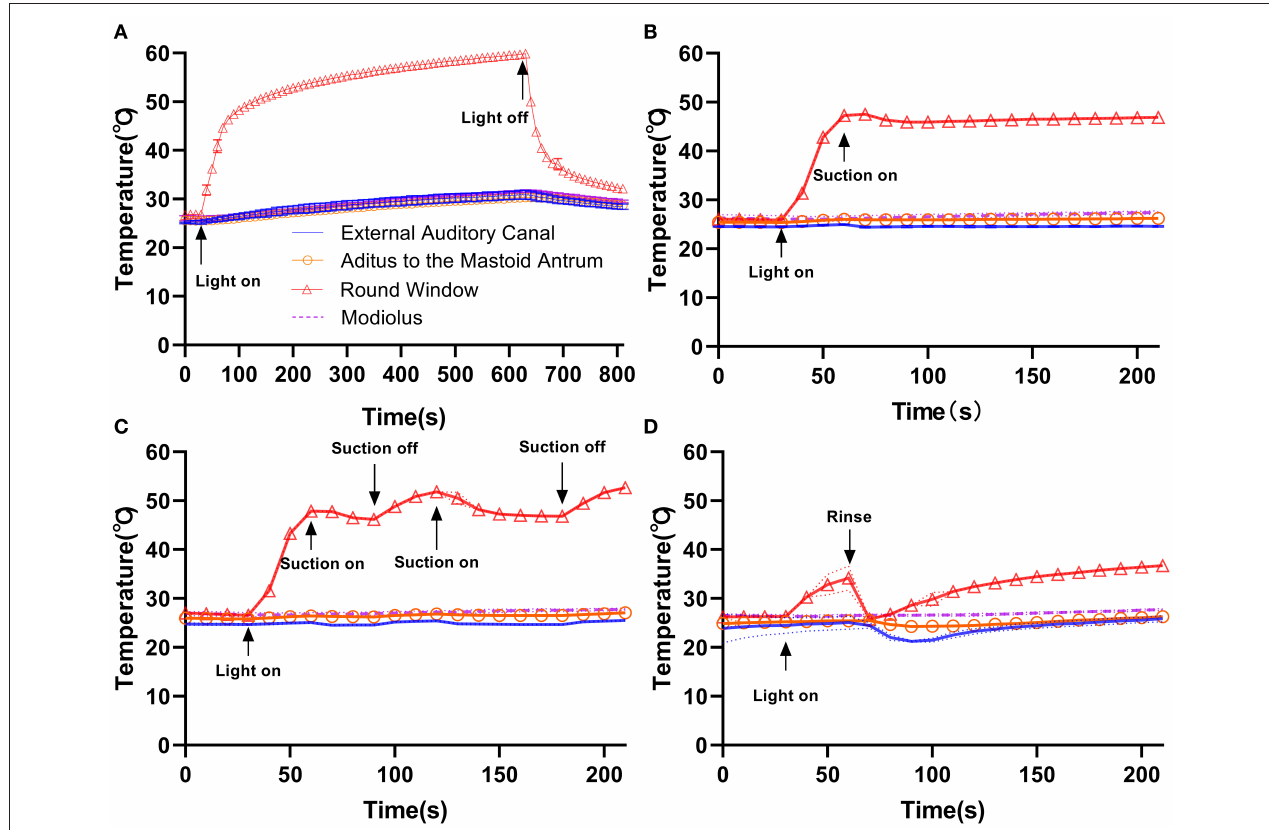
FIGURE 4 | Compared with the control group (A) , continuous suction (B) , discontinuous suction (C) , and rinsing (D) resulted in different cooling effects in temporal bone with the Neuro-0 endoscope under 100% xenon light source power. Rinsing resulted in a better cooling